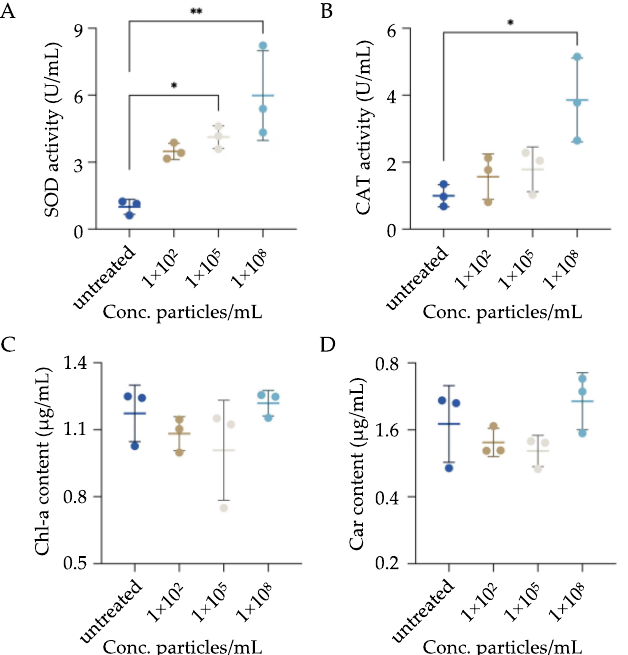
Figure 5. Analysis of oxidative stress status and endosymbiont contents in P. bursaria following MPs exposure. P. bursaria were exposed to various concentrations of MPs, and after 24 h exposure, cells were collected and processed as detailed in the Methods and Materials section to quantify the activities of antioxidant enzymes. Activities of superoxide dismutase (SOD) and catalase (CAT) of MPs-exposed P. bursaria are represented as fold change relative to the untreated group and summarized in ( A , B ). Contents of two pigments, chlorophyll-a (Chl-a) and carotenoids (Car), are summarized in ( C , D ). The data are represented as the mean ± SD of three independent experiments, and asterisks above the line denote significantly different (* p < 0.05, ** p < 0.01) between means identified by the line.